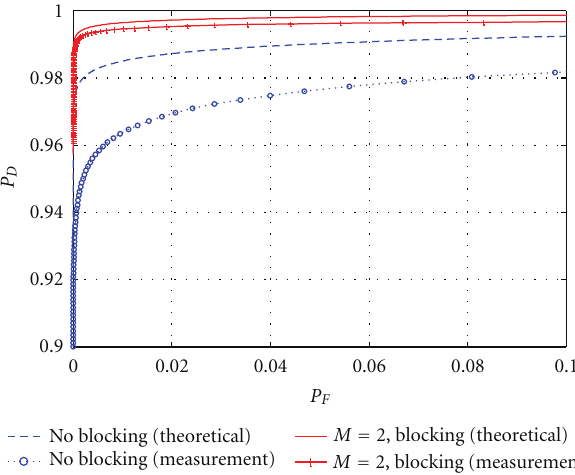
Figure 4: Measured and theoretical ROC curves at η = 21